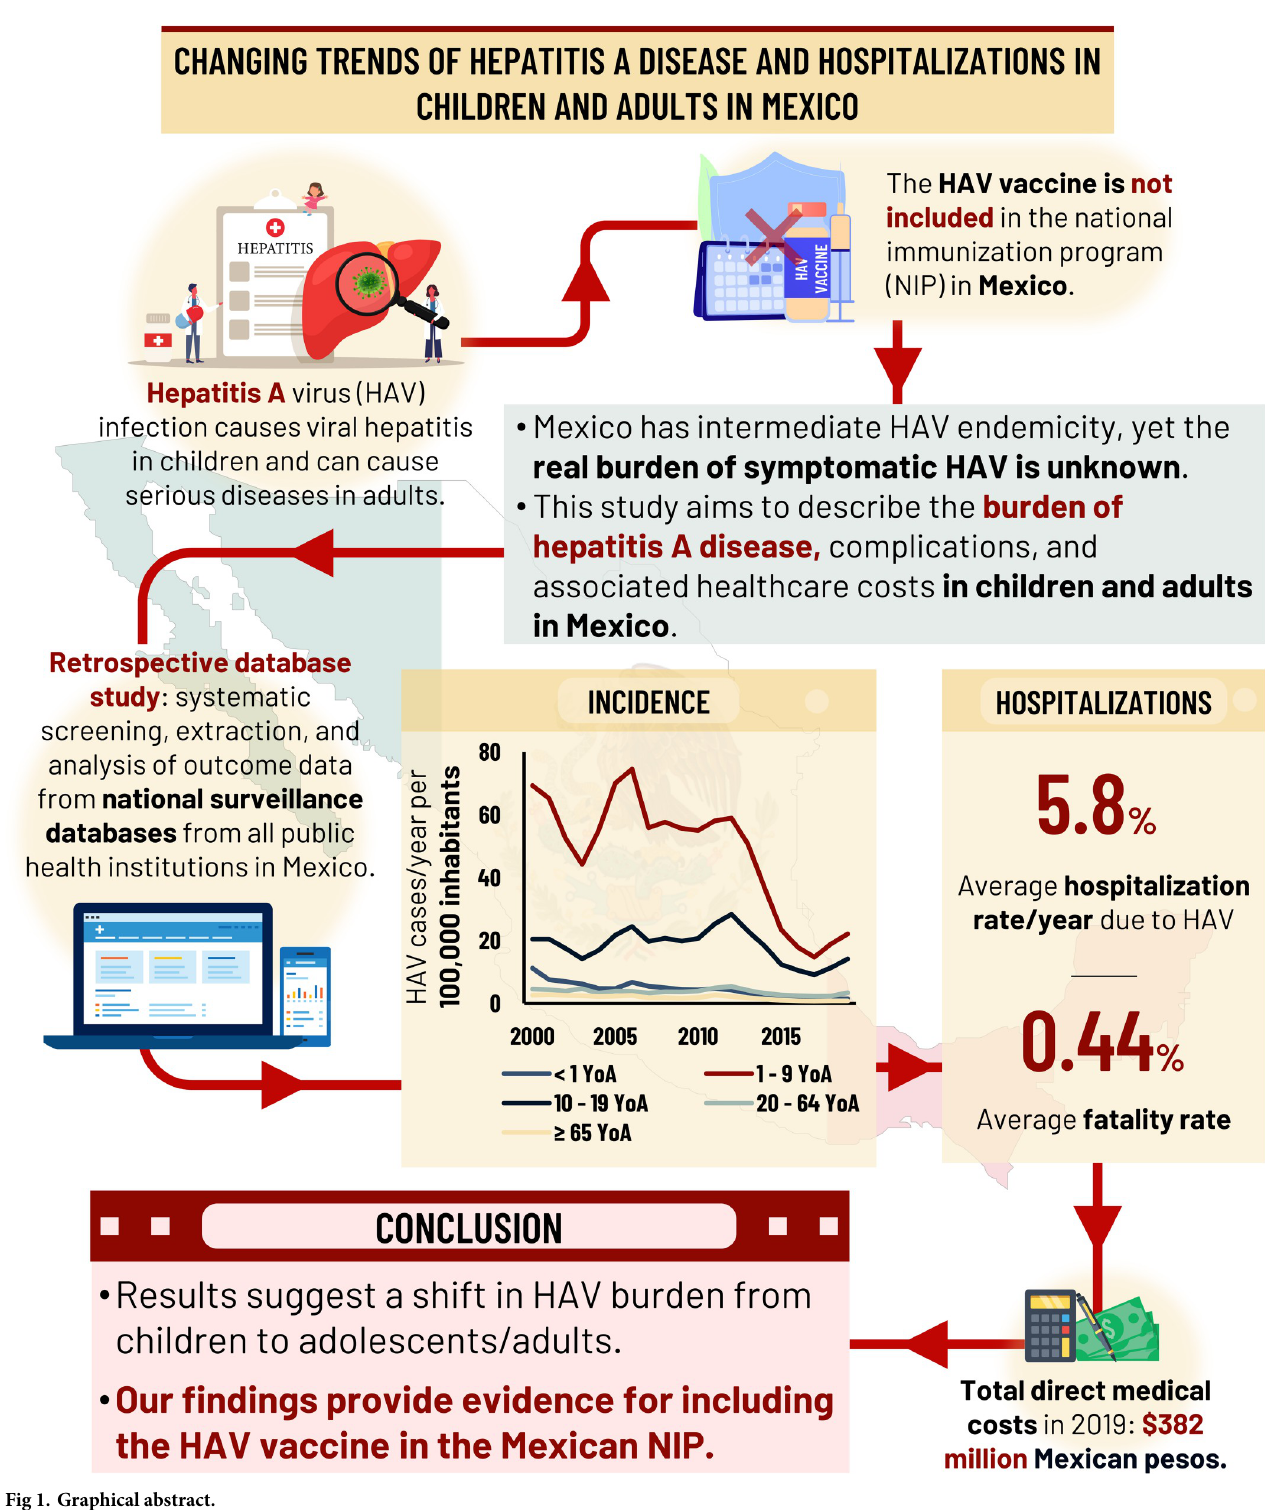
Fig 1. Graphical abstract.